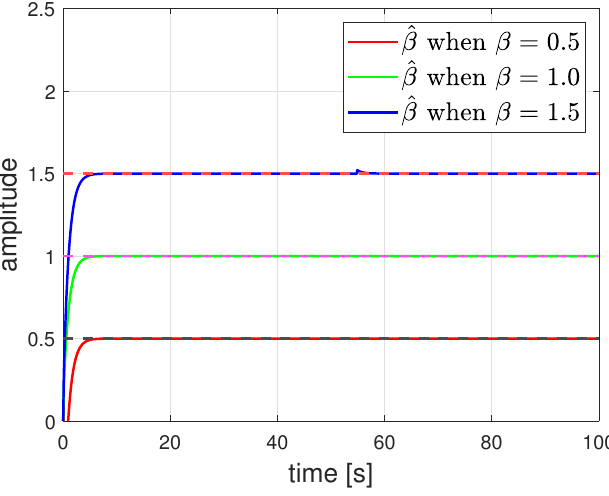
Figure 1. Friction coefficient